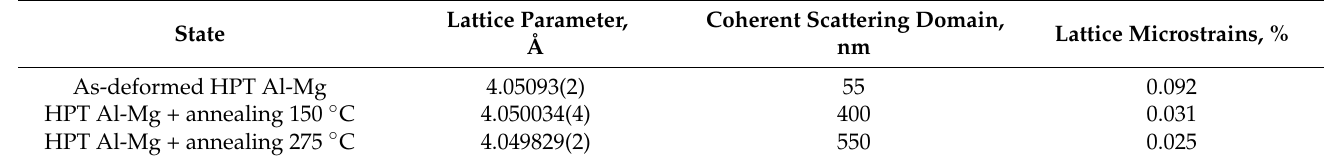
Table 1. Lattice parameter, coherent scattering domain and lattice microstrains of the Al–Mg compos- ite after HPT and subsequent annealing at 150 and 275 ◦ C.